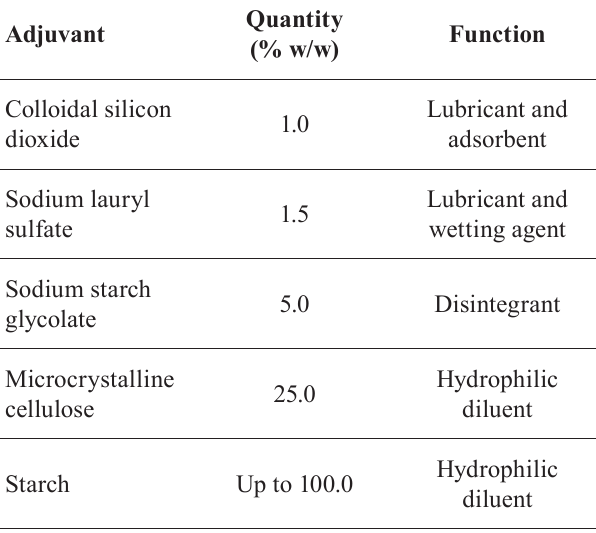
TABLE I - C omposition of the tested excipient to prepare capsules compounded in-house (T2 and